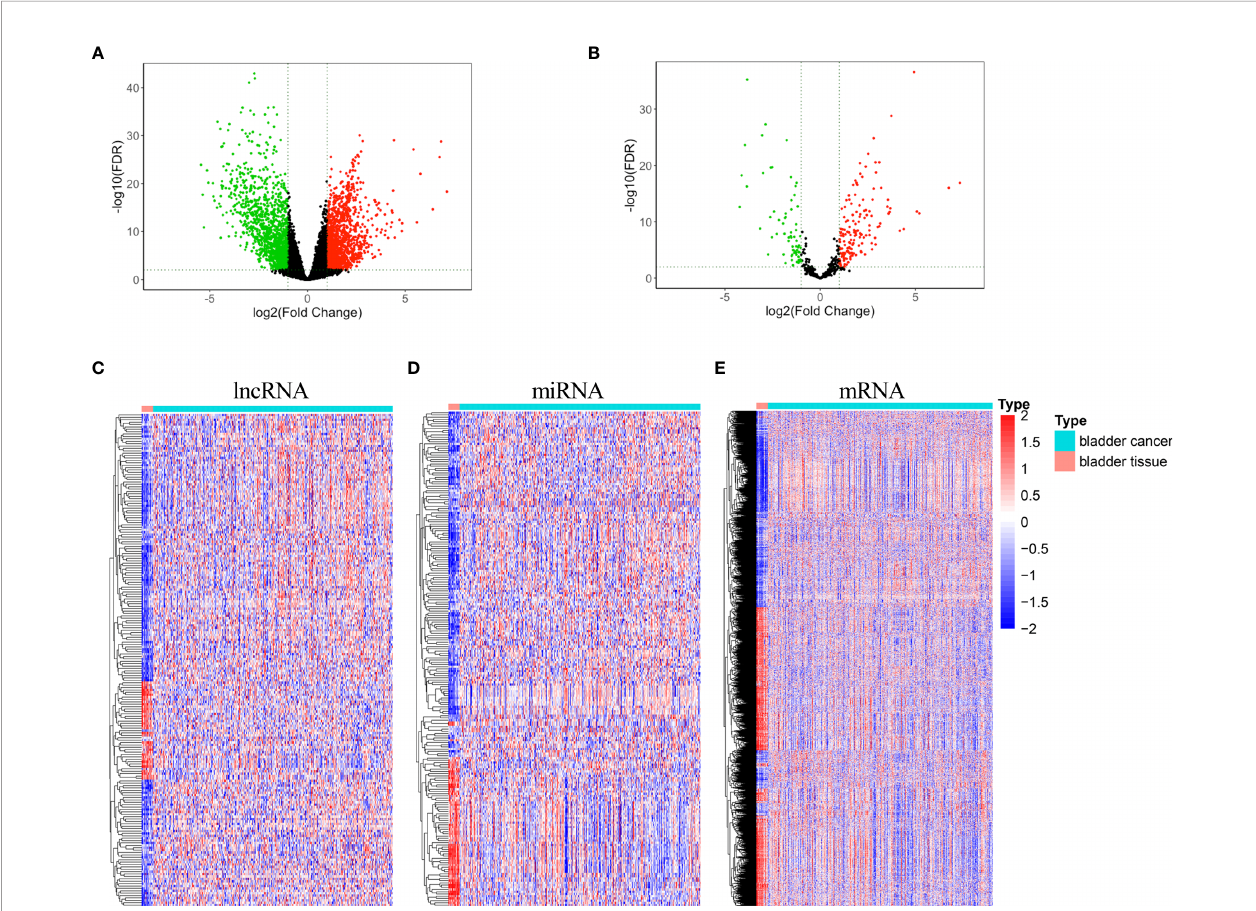
FIGURE 1 | Volcano plots and heatmaps of differentially expressed lncRNA, miRNA, and mRNA. (A) Volcano plot of differentially expressed mRNA and lncRNA (B) Volcano plot of differentially expressed miRNA. (C) Heatmap of differentially expressed lncRNA. (D) Heatmap of differentially expressed miRNA. (E) Heatmap of differentially expressed